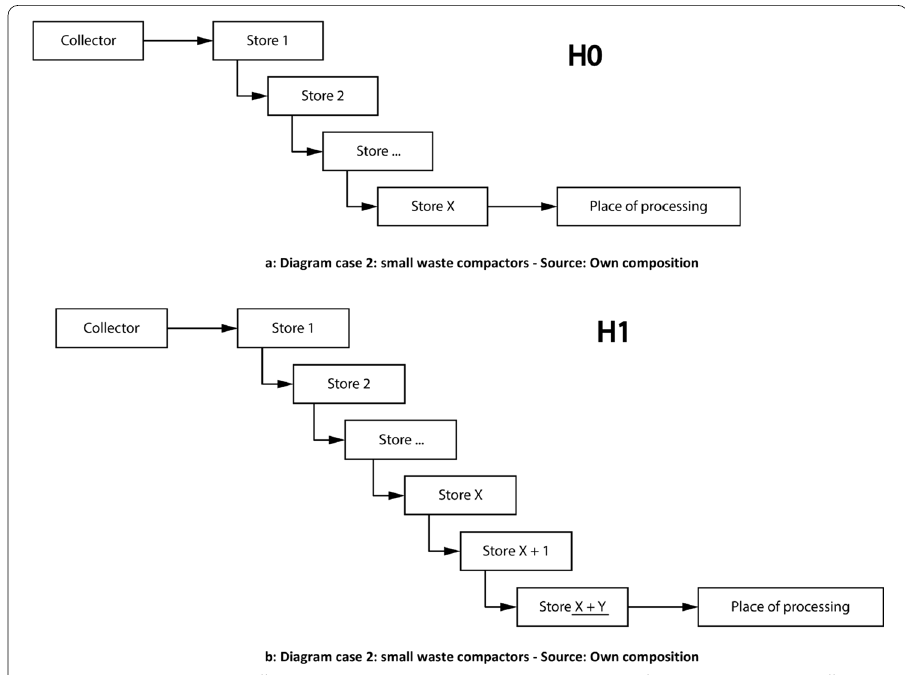
Fig. 7 a: Diagram case 2: small waste compactors. Source: Own composition. b: Diagram case 2: small waste compactors—Source: Own